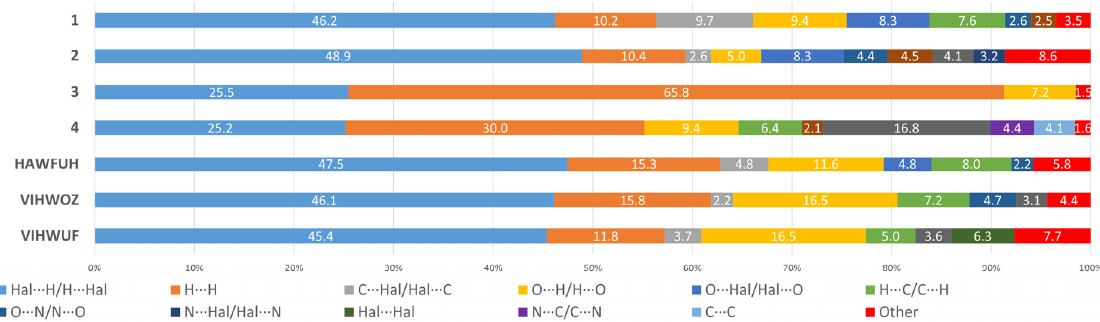
Figure 5. Percentage contributions of contacts to the Hirshfeld surface in structures 1 – 4 and analogues taken from CSD. HAWFUH: ( µ 2-oxo)-bis(dibromo-bis(pyridazine)-oxo-rhenium) acetone solvate [24]; VIHWOZ: ( µ 2-Oxo)-bis( µ 2-pyridazine)-tetrachloro-dioxo-di-rhenium(v) benzene solvate [25]; VIHWUF: ( µ 2-Oxo)-bis( µ 2-pyridazine)-tetrabromo-dioxo-di-rhenium(v) acetonitrile solvate